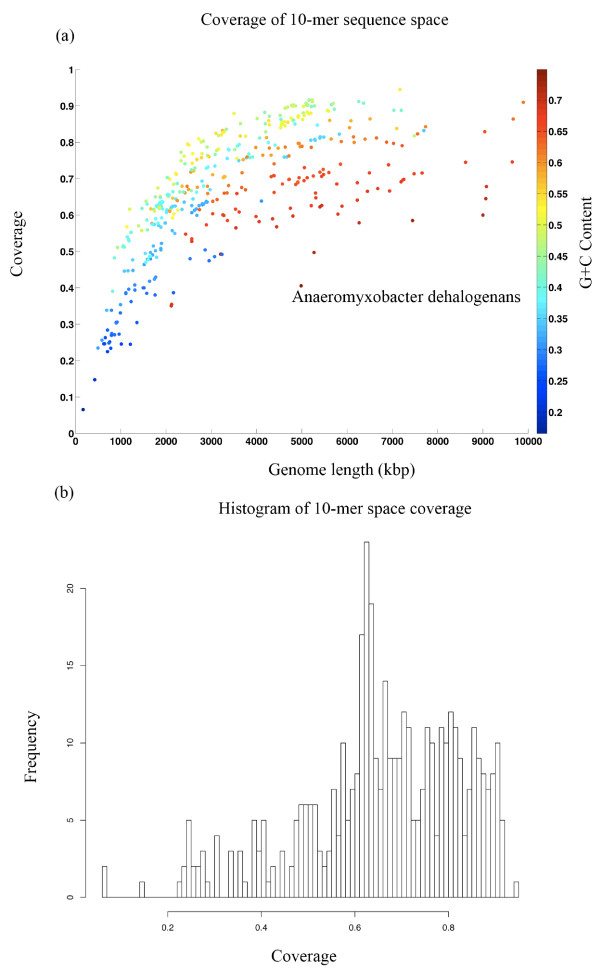
(a) Coverage of 10-mer sequence space as a function of genome size in 433 fully sequenced microbial genomes. The legend for the color-coding of GC content appears on the right. Smaller genomes have lower GC content. Anaeromyxobacter dehalogenans is an outlier with unusually low coverage for its genome size and GC content (outside of the 99.9% predicted interval). (b) A histogram for the proportion of the 10-mer sequence space covered by each of the 433 fully sequenced microbial genomes.